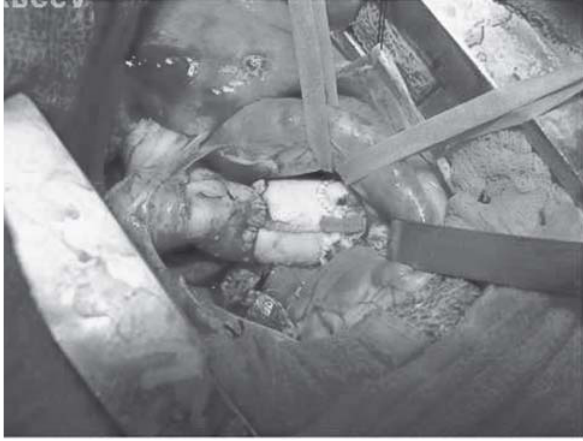
Fig. 2 - Aspecto final da